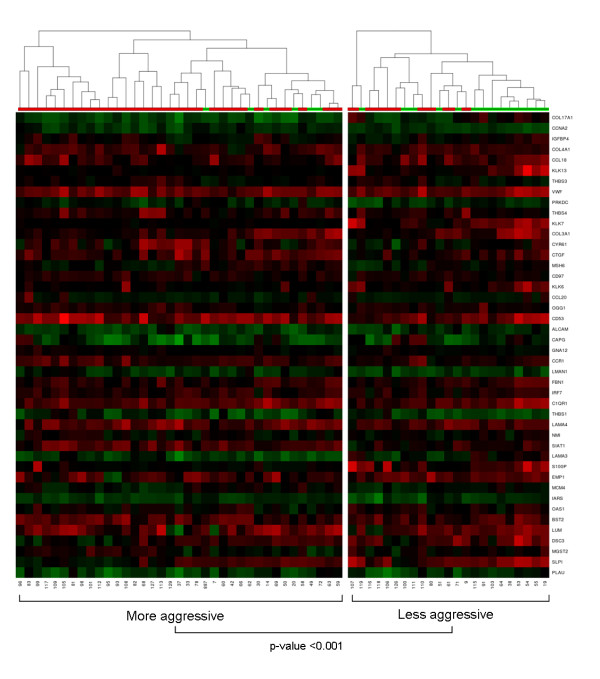
Hierarchical representation of self-organizing maps (SOM) clustered samples based on the expression profiles of biologically meaningful modules. The clustering of PCM and MM samples was based on similarities in the expression profiles of 44 non-redundant genes that contributed most significantly (cut off set as 10-3.3) to the change in the status of all 22 modules identified in this study. The SOM heatmap shows PCM samples by green bars and MM samples by red bars. Red: higher expression in the tumor than the reference mRNA; green: lower expression than the reference; black: no change compared to the reference.